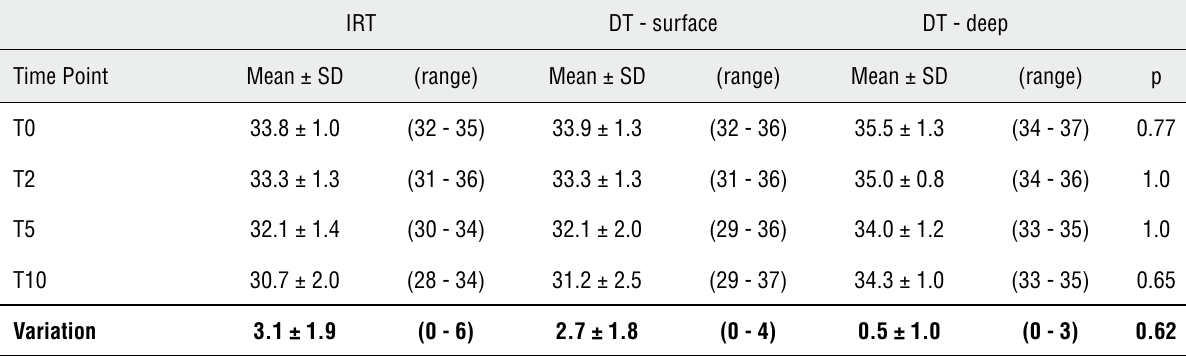
Table 2 - Comparative analysis of temperature decrease during warm renal ischemia